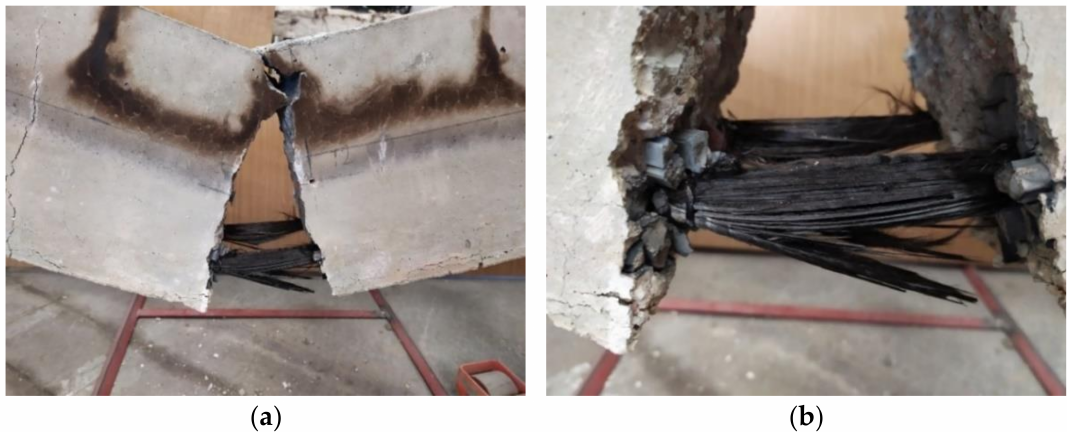
Figure 5. Destruction of specimen B2Ø14: ( a ) non-magnified image; ( b ) magnified